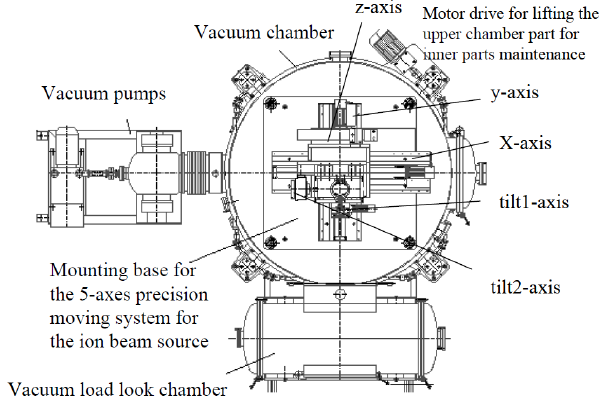
Figure 26. The series of collision processes [187].